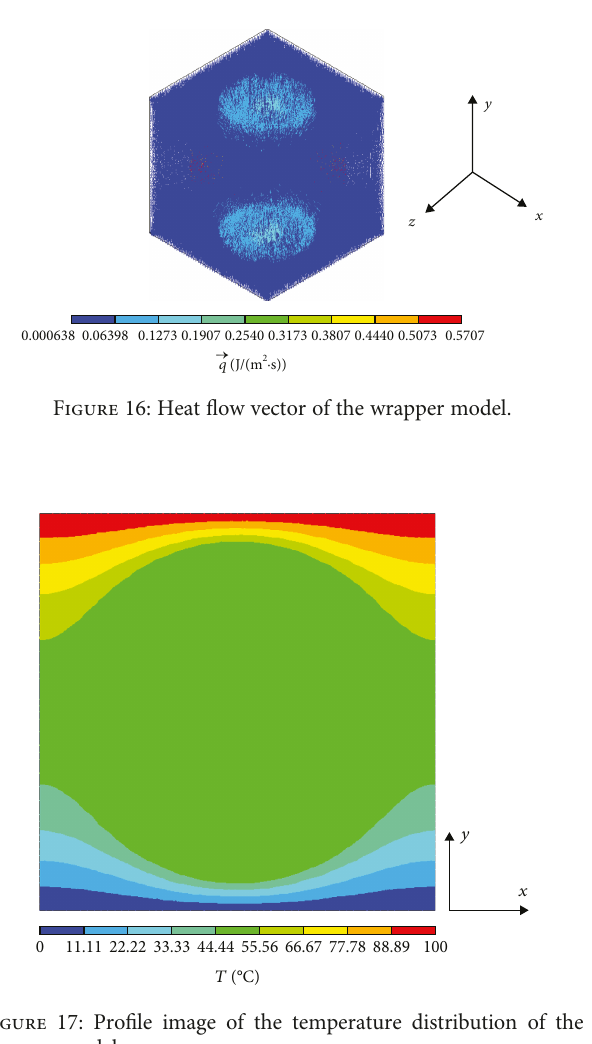
Figure 15: Temperature distribution of the wrapper model.